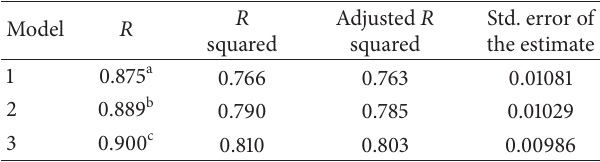
Table 2: Model summary showing 𝑅 2 , adjusted 𝑅 2 , and standard error of the estimate.